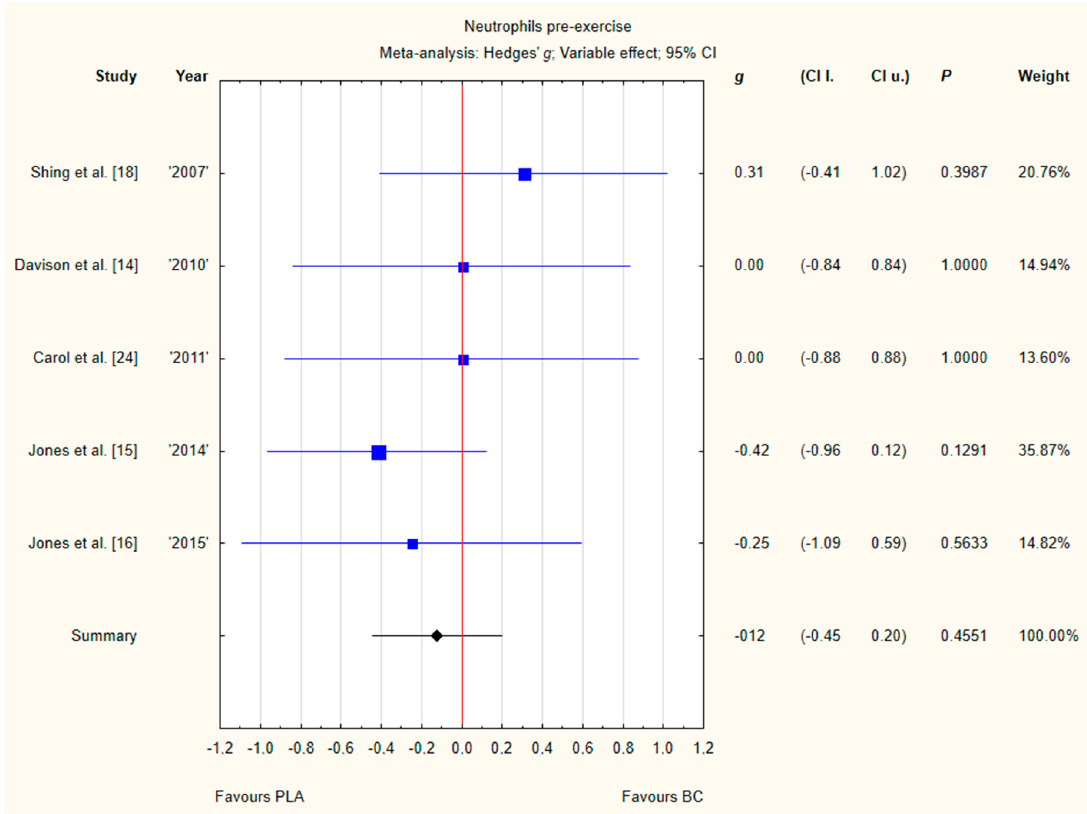
Figure 5. Forest plot of the random-effects meta-analysis of changes in neutrophils concentration. Heterogeneity: Tau 2 = 0; Chi 2 = 2.79; df = 4; I 2 = 0%; P = 0.5933. Abbreviations: BC–bovine colostrum,